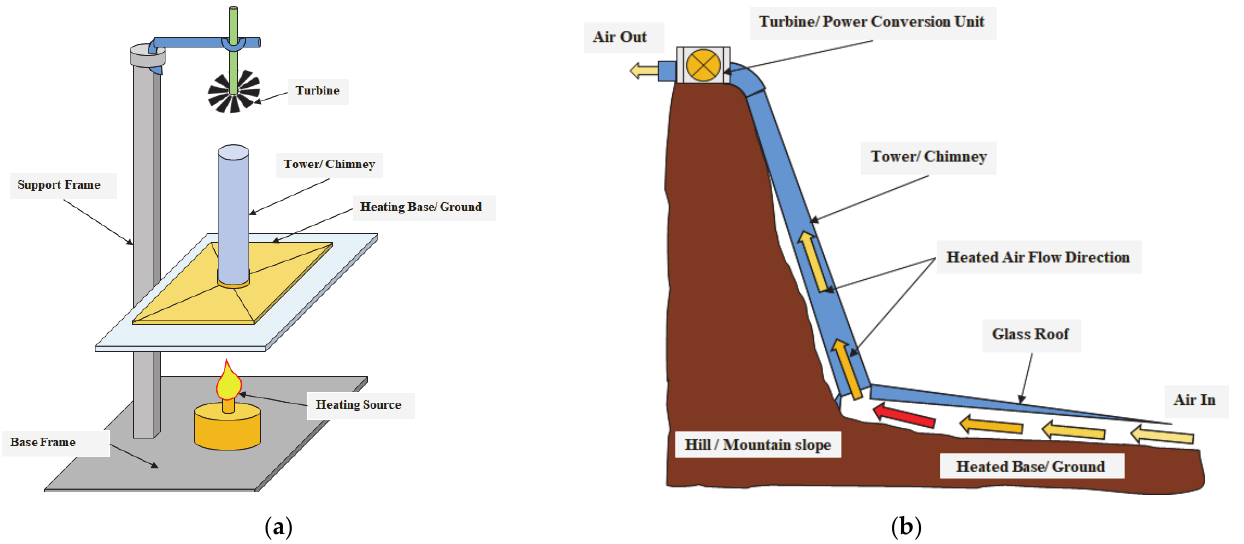
Figure 1. ( a ): Schematic of an experimental setup of a solar chimney, ( b ) schematic of a sloped chimney power plant proposed by Günter, 1931.